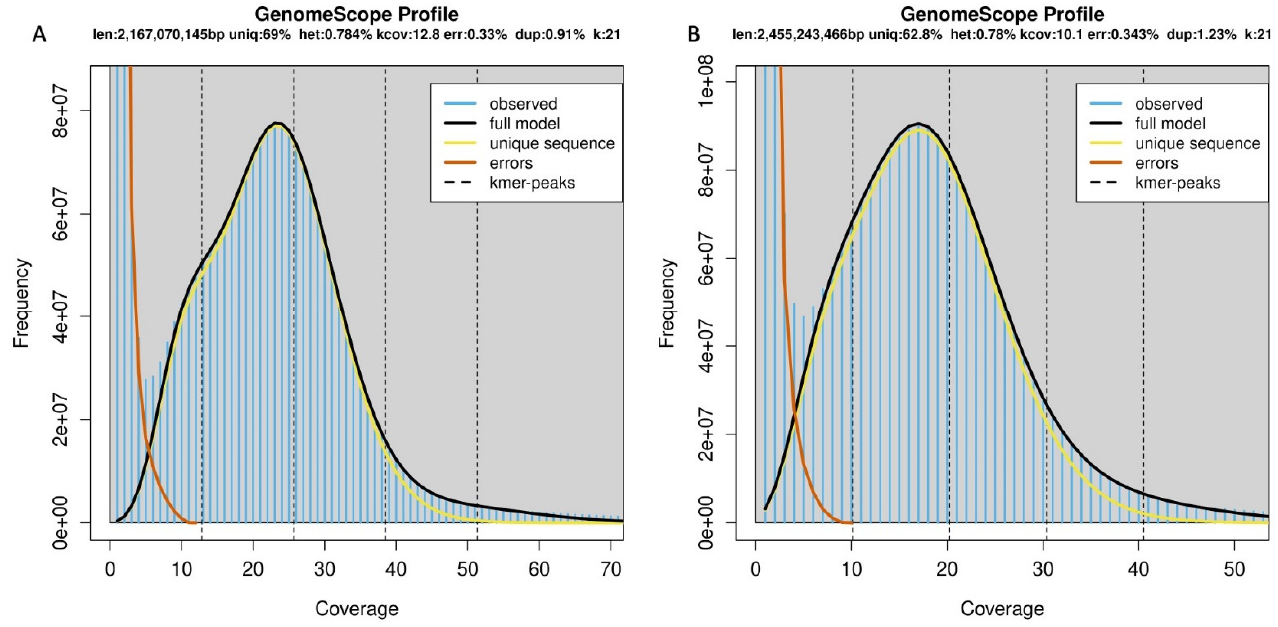
Figure 15. Results of K-mer analysis. See text for details.